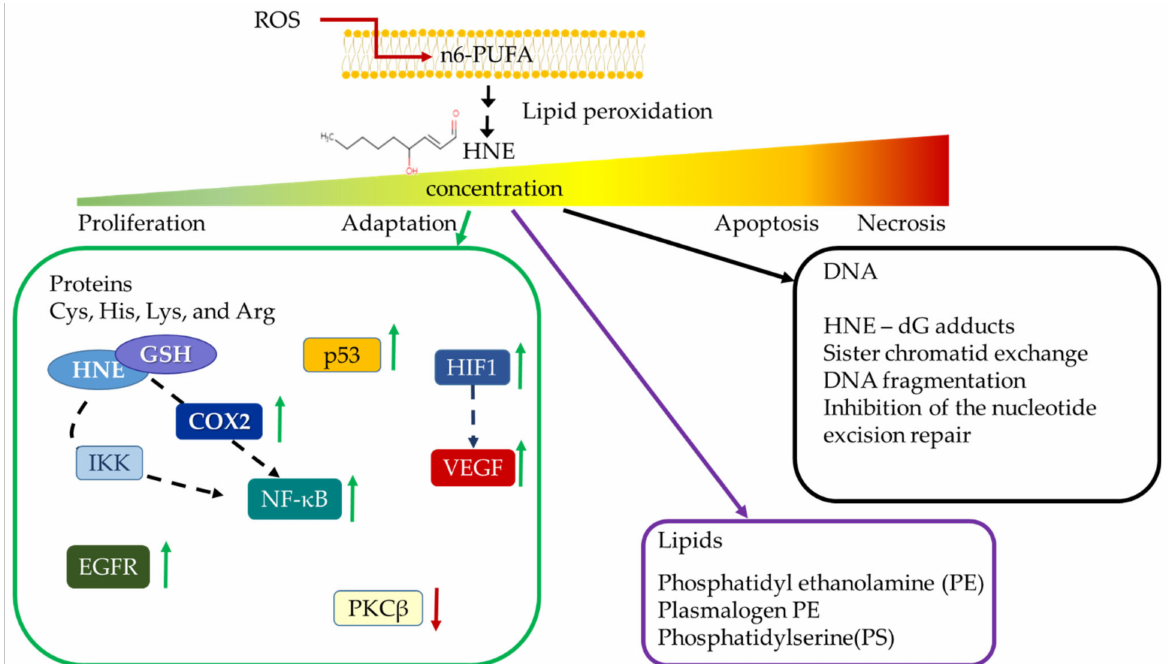
Figure 1. Interactions of HNE with cellular proteins, lipids and DNA. HNE is an end-product of n6-polyunsaturated fatty acids (n6-PUFA) peroxidation which acts in a concentration dependent manner. Low concentrations: interaction with DNA (black arrow) results in forming exocyclic guanine adducts [24]. High concentrations: occurrence of sister chromatid exchange, DNA fragmentation [19], and inhibition of nucleotide excision repair [25]. HNE also binds to membrane lipids (purple arrow) [20]. Interactions with proteins are much more complex, as HNE directly or indirectly causes an increase (green arrows) or decrease (red arrow) in the activity or expression of Nuclear Factor Kappa-Light-Chain-Enhancer of Activated B Cells (NF- κ B), Cyclooxygenase 2 (COX2), Hypoxia- Inducible Factor (HIF1) Vascular Endothelial Growth Factor (VEGF), TP53 and Epidermal Growth Factor Receptor (EGFR) [17,26]. Interactions with NRF2 will be reviewed